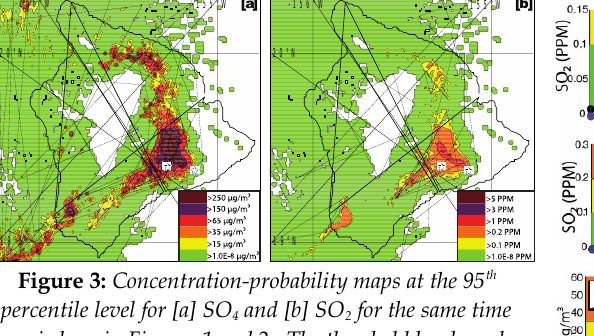
Figure 3: Concentration-probability maps at the 95 th percentile level for [a] SO 4 and [b] SO 2 for the same time periods as in Figures 1 and 2. The threshold levels and color table for SO 2 correspond to Hawai’i Department of Health standards and those of SO 4 correspond to PM2.5 levels established by the EPA. Within a contour, 5% of the members (2 of 27) predict a higher concentration than the one given by the contour, and outside of it, 95% of the models in the ensemble (25 of 27) predict a lower con- centration. Figure 4: Sulfur dioxide and sulfate aerosol (SO 4 ) timeseries for locations downwind of the vog sources (Mountain View and Hilo). Background colors reflect the threshold values shown in Figure 3. Observations for sulfate aerosol actually fall under PM2.5, so values re- flect constituents other than